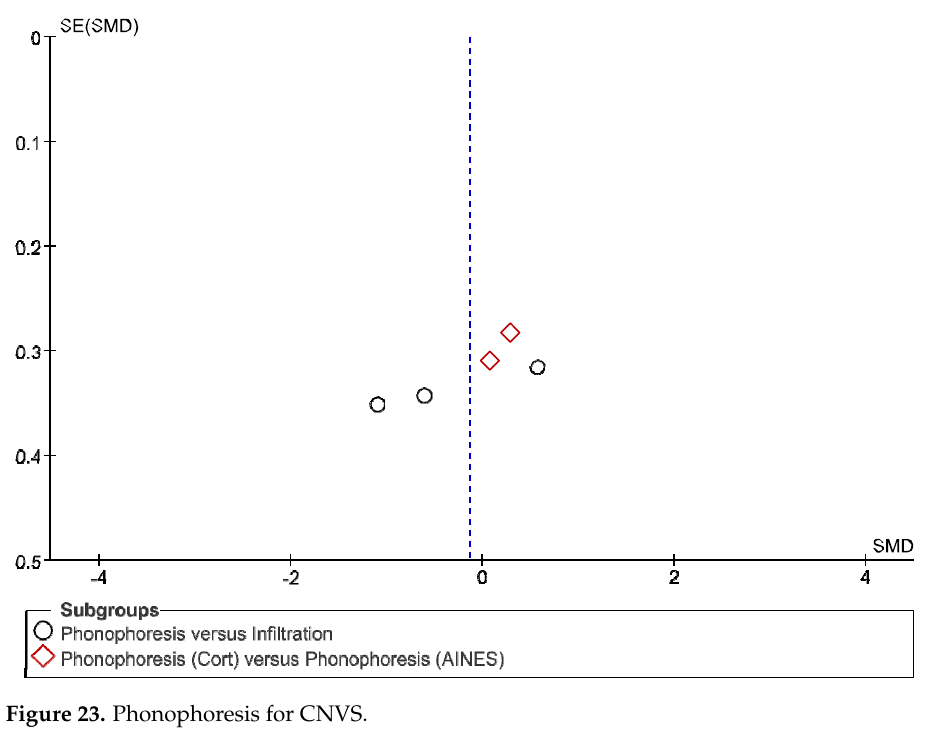
Figure 23. Phonophoresis for CNVS.